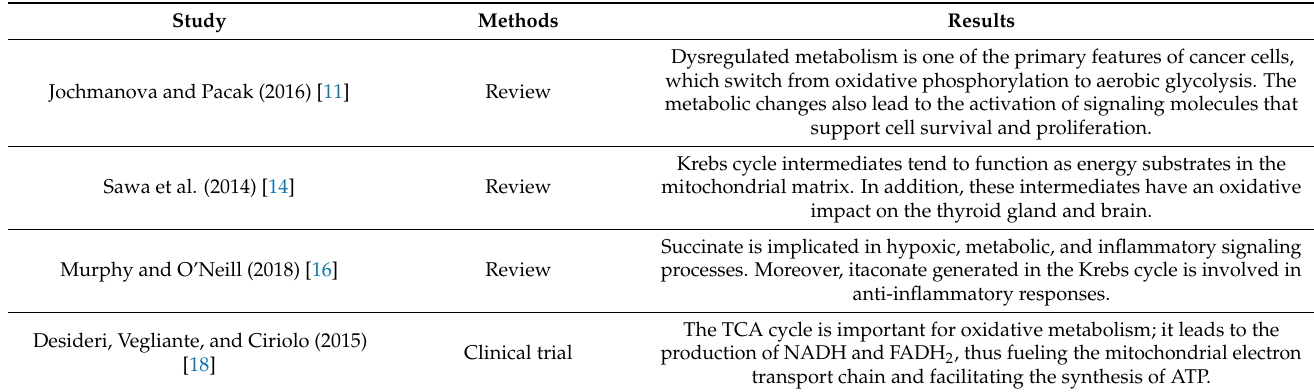
Table 1. Summary of the 20 main